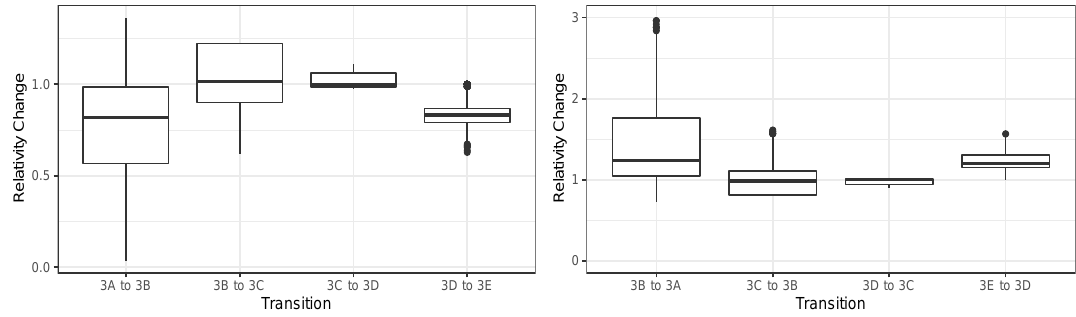
Figure 8. Relativity impact of the transition from one group to